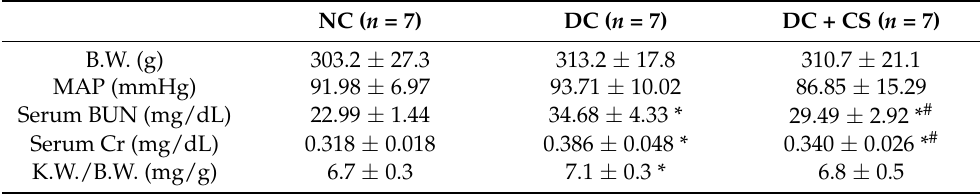
Table 1. Functional parameters of rats with chronic glomerulonephritis at week 4.